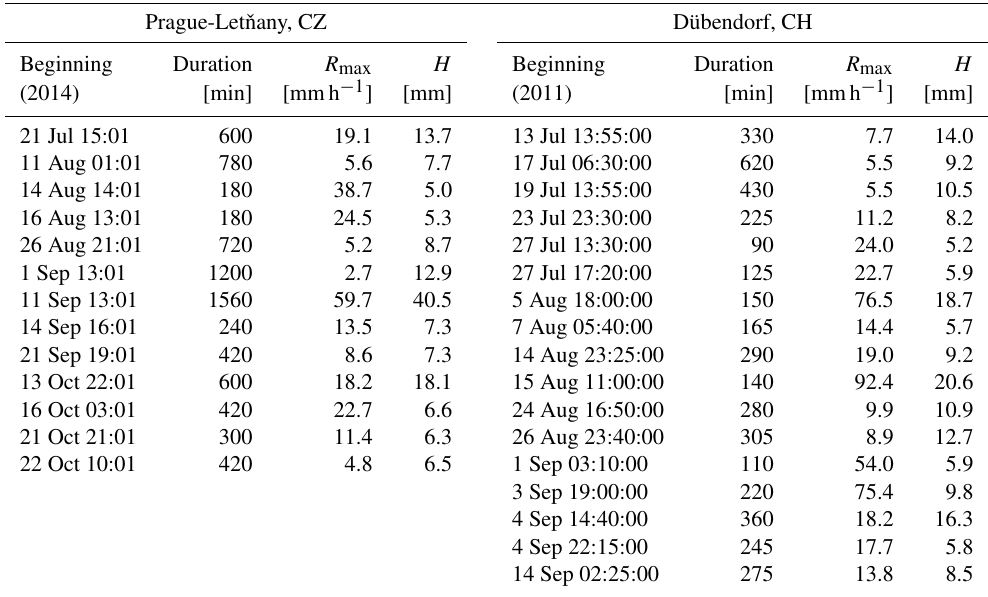
Table 1. Rainfall events selected for the evaluation at Prague-Letˇnany site, CZ, in 2014 and Dübendorf site, CH, in 2011. The maximal intensity R max and the total rainfall amount H are provided for each event. Short convective rainfalls with peak intensities up 90mmh − 1 and long low-intense stratiform rainfalls are included in the datasets. Prague-Letˇnany, CZ Dübendorf,